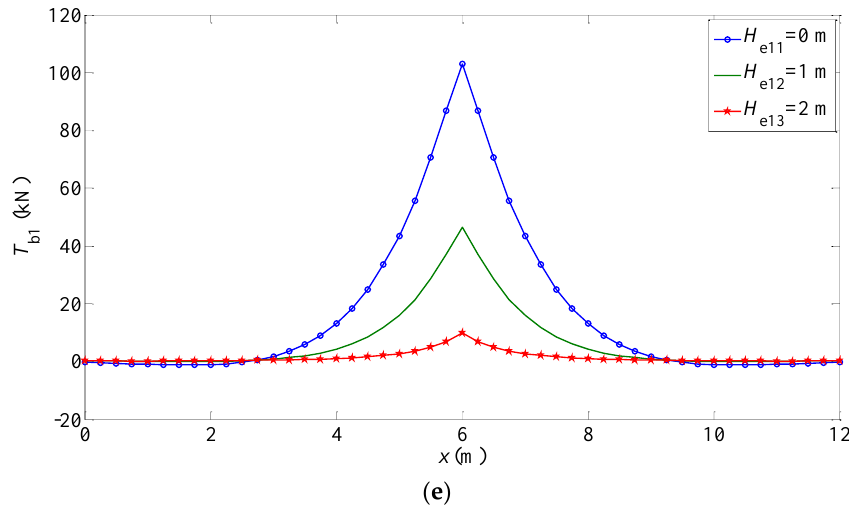
Figure 6. Mechanical behavior of a beam embedded in a Gibson elastic foundation ( η 2 = 2). ( a ) Displacement of a beam embedded in a Gibson elastic foundation ( η 2 = 2); ( b ) rotation angle of a beam embedded in a Gibson elastic foundation ( η 2 = 2); ( c ) bending moment of a beam embedded in a Gibson elastic foundation ( η 2 = 2); ( d ) shear force of a beam embedded in a Gibson elastic foundation ( η 2 = 2); ( e ) subgrade force of a Gibson elastic foundation ( η 2 = 2).